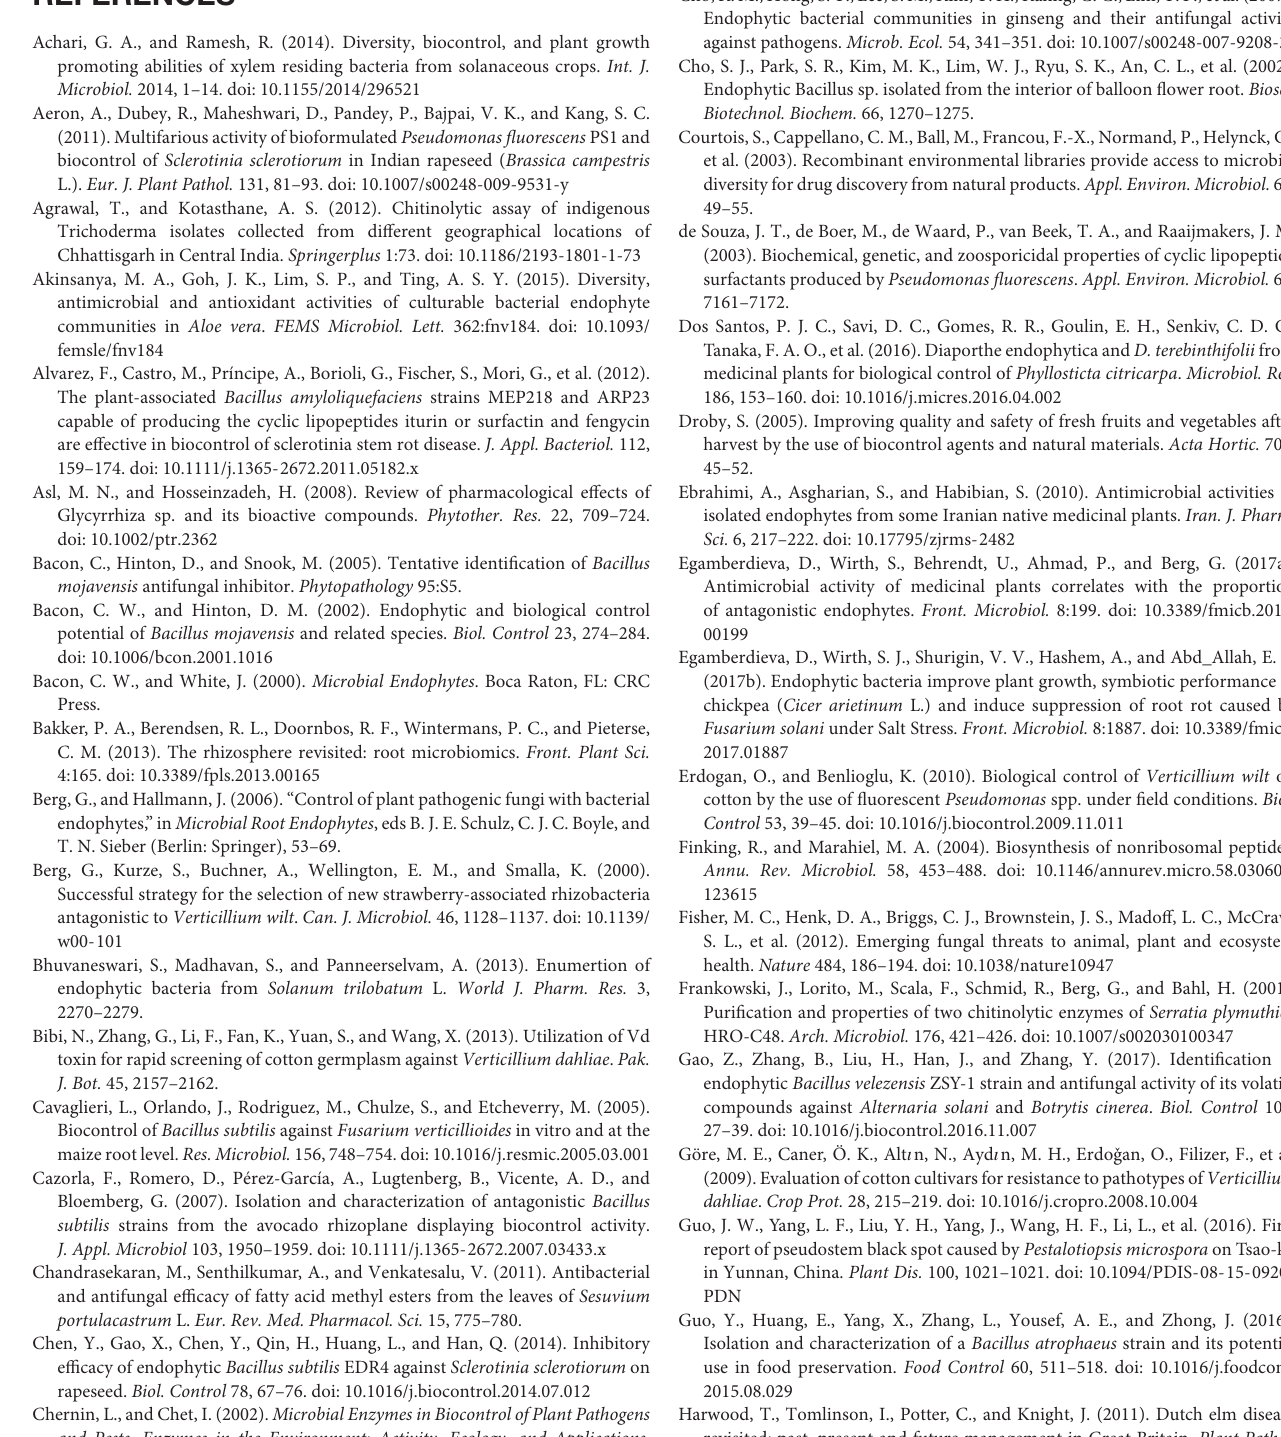
TABLE S5 | GC-MS identified components of the antibiosis crude extract of XEGI50 and V. dahliae mixture at pH7 (Volatile compounds are listed in ascending order of Retention Time).